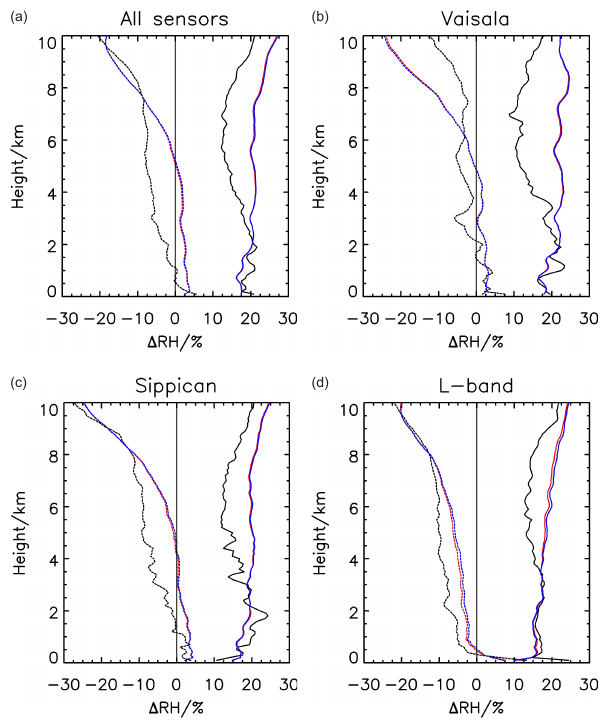
Figure 5. Bias (dashed line) and standard deviation (solid line) of the relative humidity data between the radiosonde observations and COSMIC RO retrievals. The red lines represent all observations, the blue lines represent the normal observations and the black lines represent the failed observations. Panel (a) shows the statistics for all sensors, (b) just Vaisala RS92, (c) Sippican and (d) the China L-band sensor.